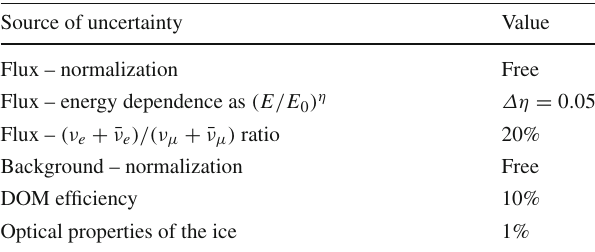
Table 2 Systematic errors used in our analysis of DeepCore data, taken from Refs.